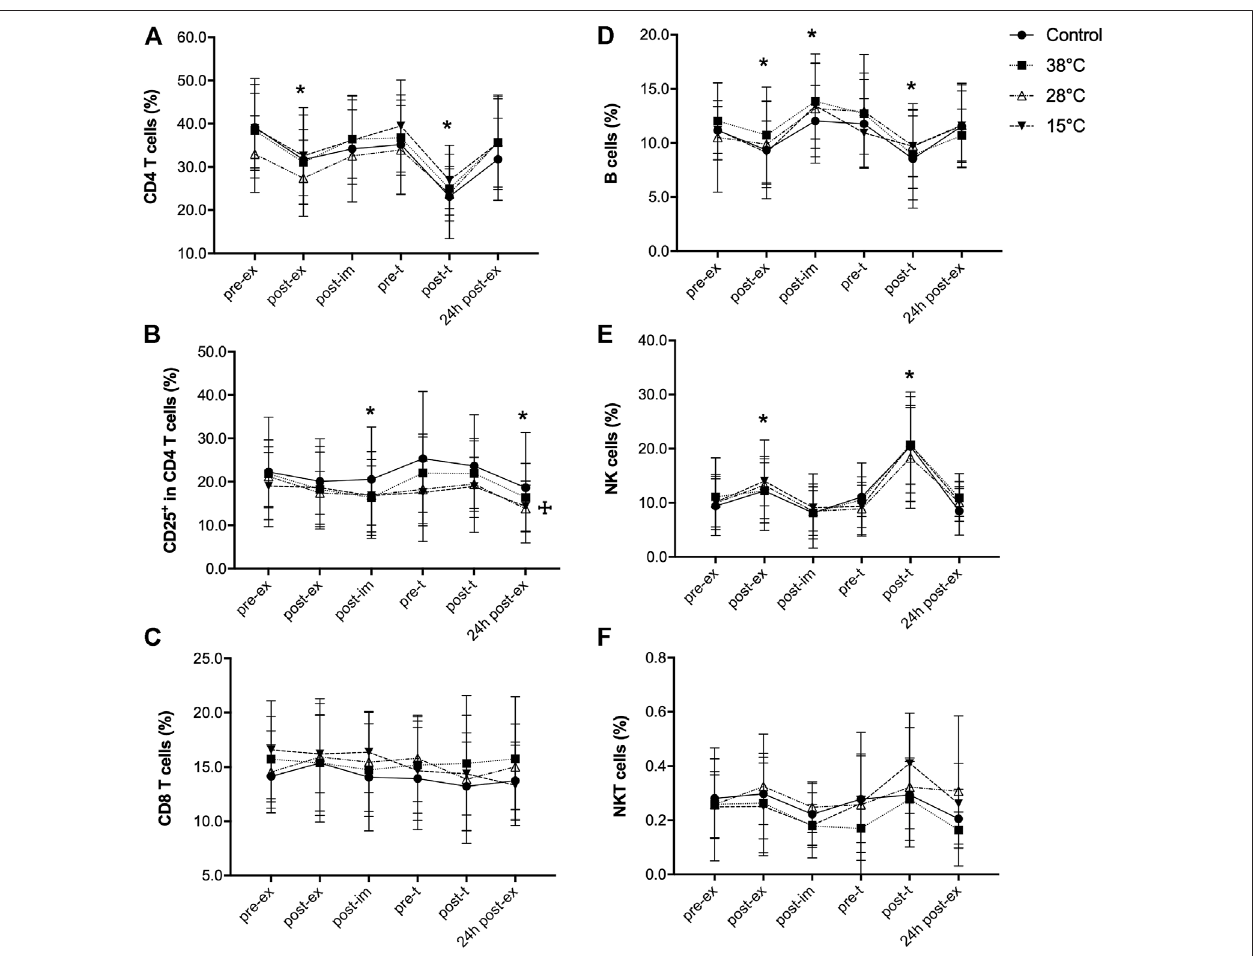
FIGURE 3 | Effect of exercise recovery by water immersion on the percentage of blood lymphocyte subpopulations. CD4 T cells (A) , CD25 + in CD4 T cells (B) , CD8 T cells (C) , B cells (D) , NK cells (E) and NKT cells (F) . * p < 0.05, main time effect, compared to pre-ex, mixed-effects analysis, followed by Dunnett ’ s multiple comparisontest. ☩ p < 0.05,maintreatment effect,28 ° Cand15 ° Cversuscontrol,mixed-effectsanalysis,followedbyDunnett ’ smultiplecomparisontest. Pre-ex –